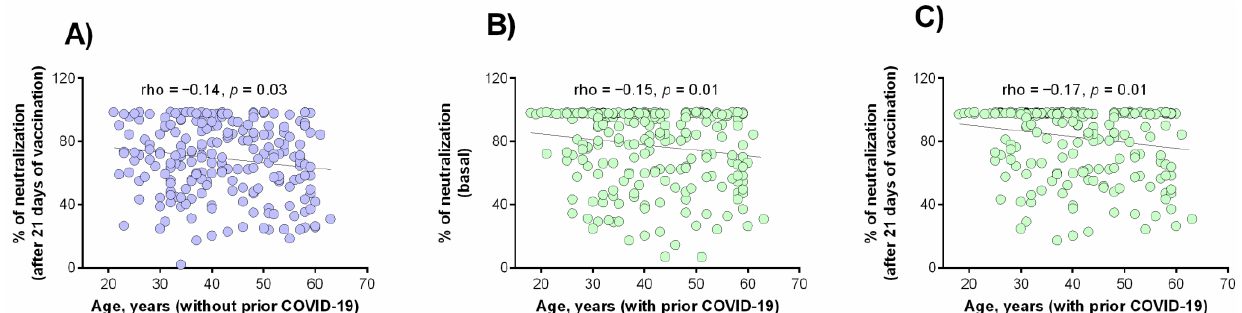
Figure 4. Correlation between the age and neutralization percentage. ( A ) After 21 days of vaccination in patients without prior COVID-19; ( B ) in basal status in patients with prior COVID-19; ( C ) after 21 days of vaccination in patients with prior COVID-19. Analysis was evaluated by the Spearman’s rank correlation coefficient.